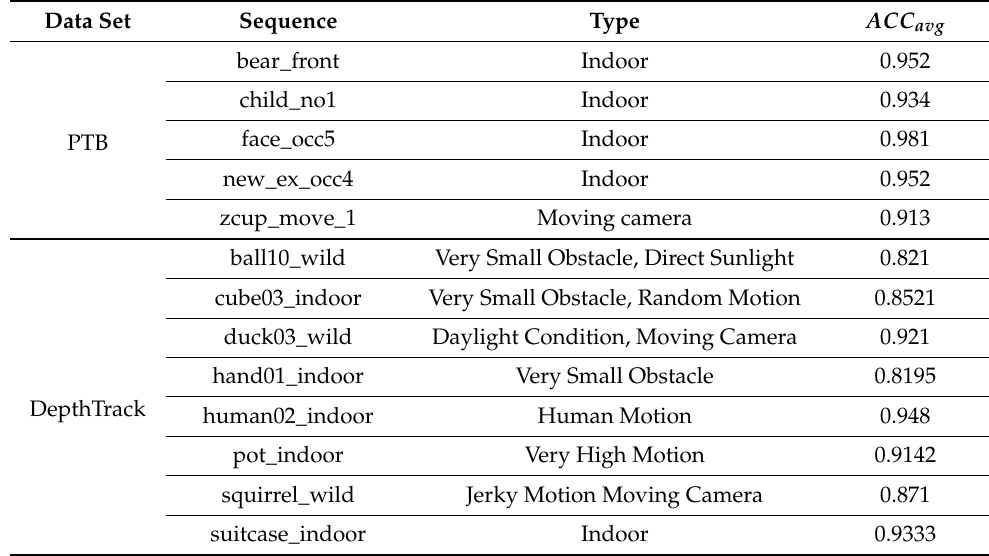
Table 2. Experimental evaluation on PTB [1] and DepthTrack [22] data